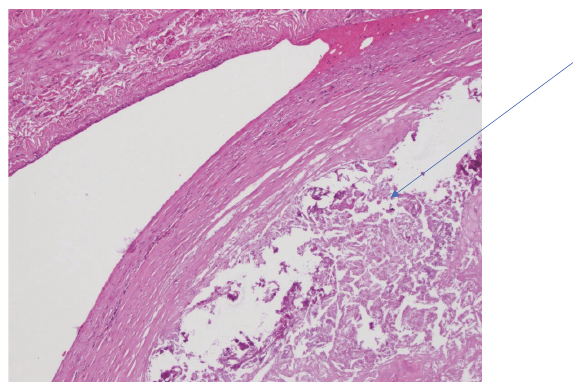
Figure 8: Necrotic tumor in renal